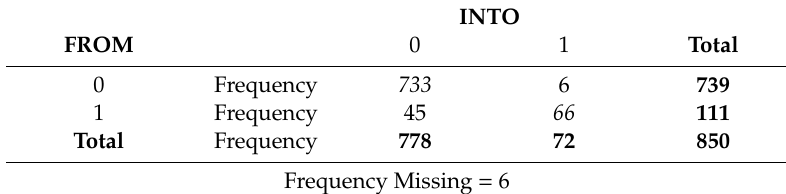
Table 7. Classification table for model.